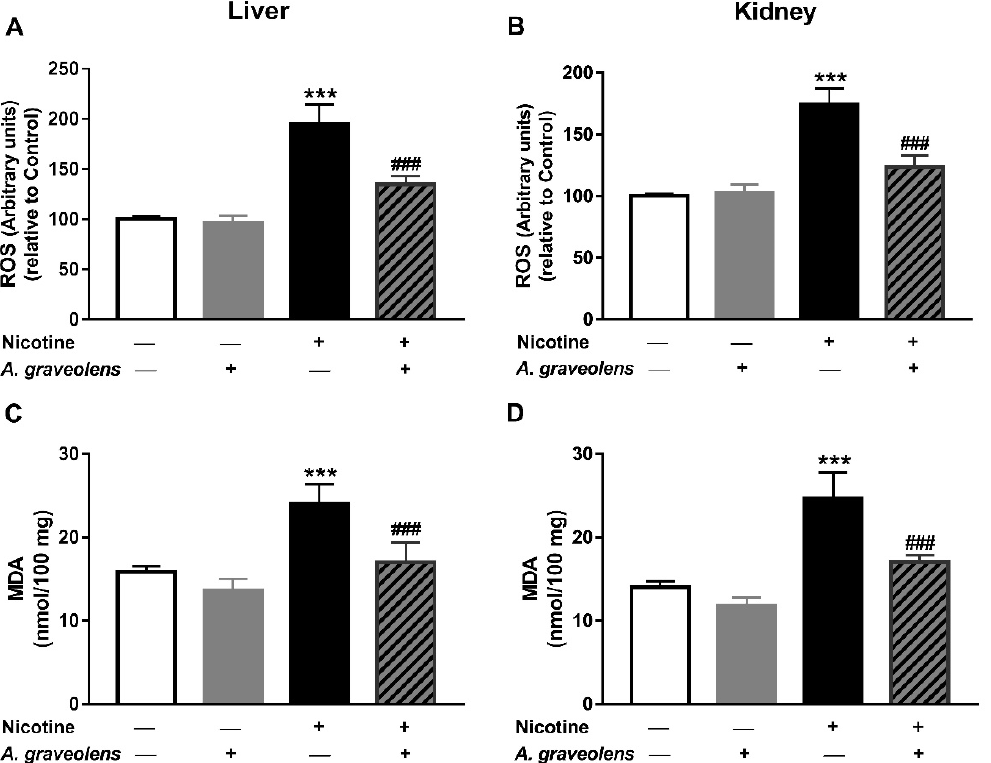
Figure 5. A. graveolens decreased reactive oxygen species (ROS) and malondialdehyde (MDA) in liver ( A , C ) and kidney ( B , D ) of nicotine-exposed mice newborns. Data are mean ± SEM, n = 8. *** p < 0.001 versus Control. ### p < 0.001 versus Nicotine.